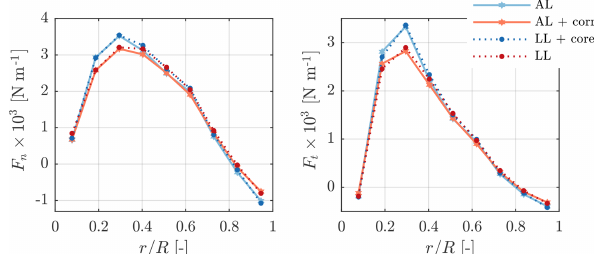
Figure 11. Normal and tangential forces on the NREL 5-MW blades at 25ms − 1 predicted by AL simulations with/without smear- ing correction and LL with/without viscous core ( N s = 9, (cid:15) = 0 . 2 R